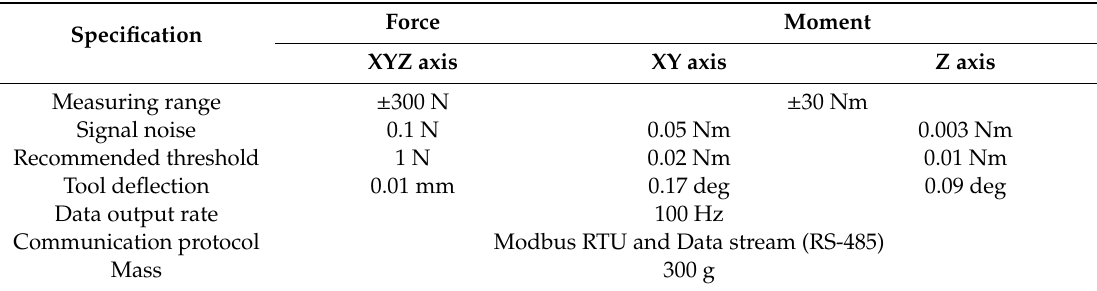
Table 2. Robotiq force torque sensor FT300 specifications.